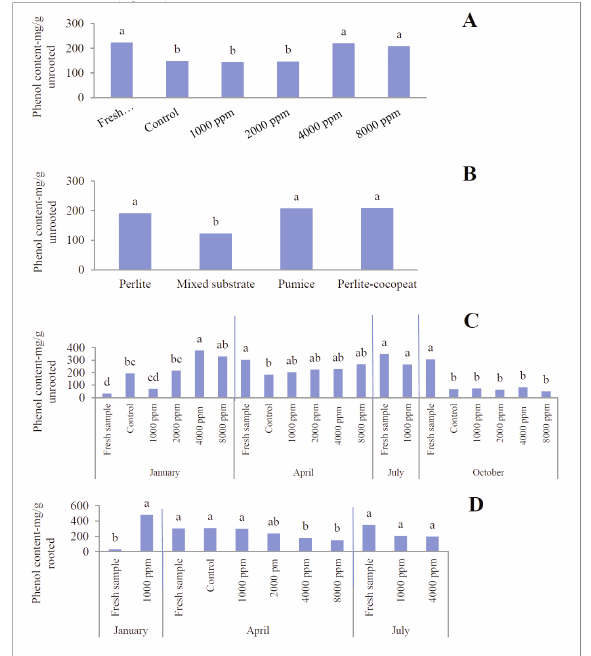
Fig. 9 ­ A, B, C, D Mean internal phenol content within seasons for the different treatments with IBA for rooted and unrooted cuttings (a, b, c, d). The mean values for the same letter were not significantly different at the 0.05 level according to the LSD test. 540 stem cuttings in each season were planted. For the treatments that were not represented in the figure, those cuttings have dried.